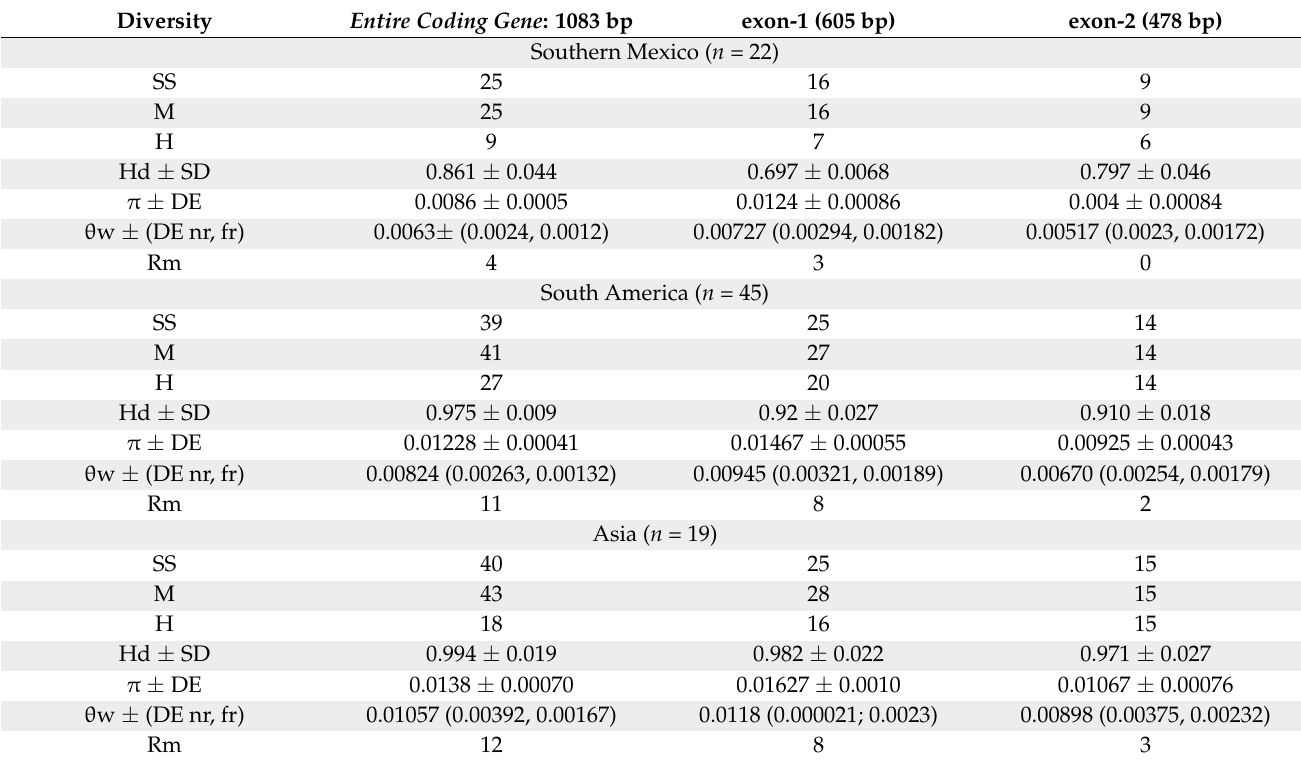
Figure 2. Slide window analysis of the diversity and Tajima’s D for the P. vivax cyrpa coding gene. Indexes of nucleotide ( π ) and genetic diversity ( θ ); Tajima’s D values varied across the sequence. Graphs show isolates from different geographical origin. Window length of 100 bp and step size of 25 nucleotides. Significance * P < 0.05; § P < 0.01. Table 3. Diversity parameters of the P. vivax cyrpa coding gene in Southern Mexican parasites, and in isolates from other geographic